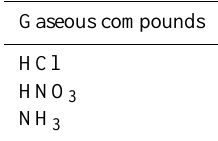
Table 4. List of the gaseous compounds given by the ISORROPIA